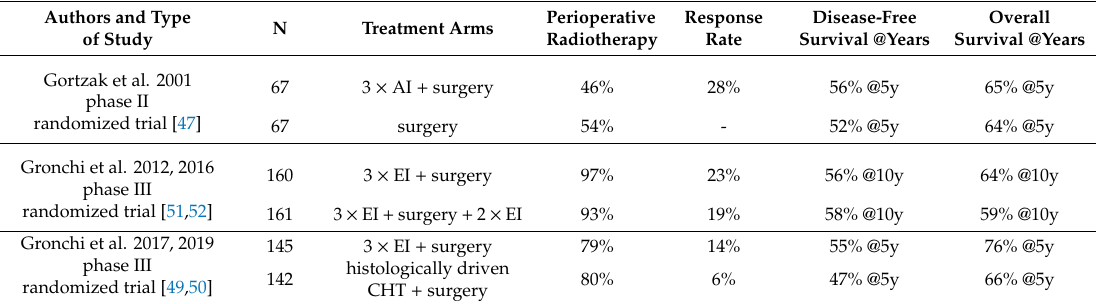
Table 2. Neoadjuvant chemotherapy in soft tissue